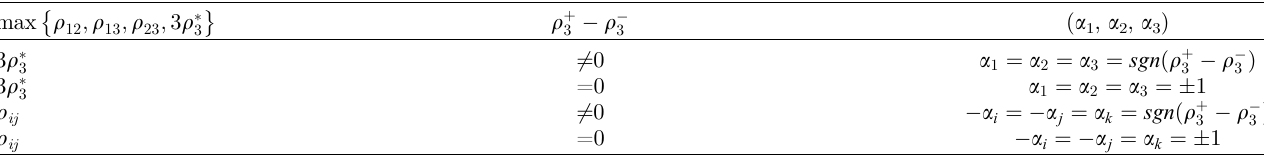
Table 1. Direction of maximal dependence ( sgn denotes the signum